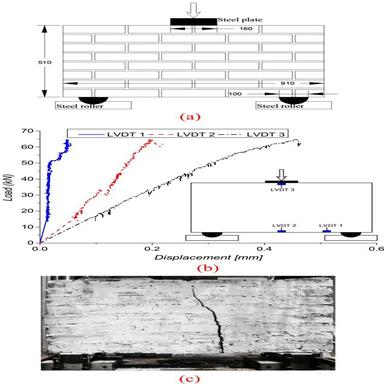
Masonry panel under flexure: (a) test setup (dimensions in mm), (b) load– displacement response, (c) failure pattern.